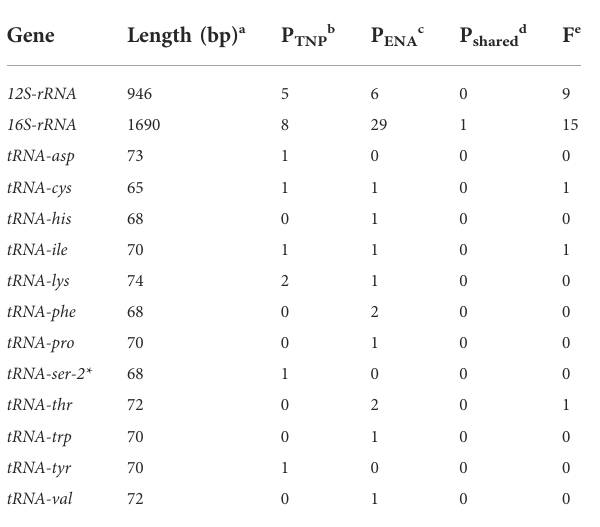
TABLE 3 Polymorphisms in non-coding mitogenomic elements between and within mitotype in threespine stickleback ( Gasterosteus aculeatus ).